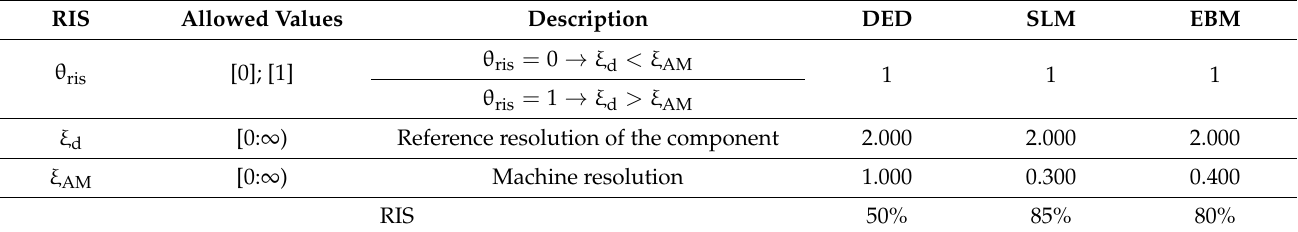
Table 5. Resolution analysis (RIS) calculation for the FDM head for traditional plastics. RIS Allowed Values